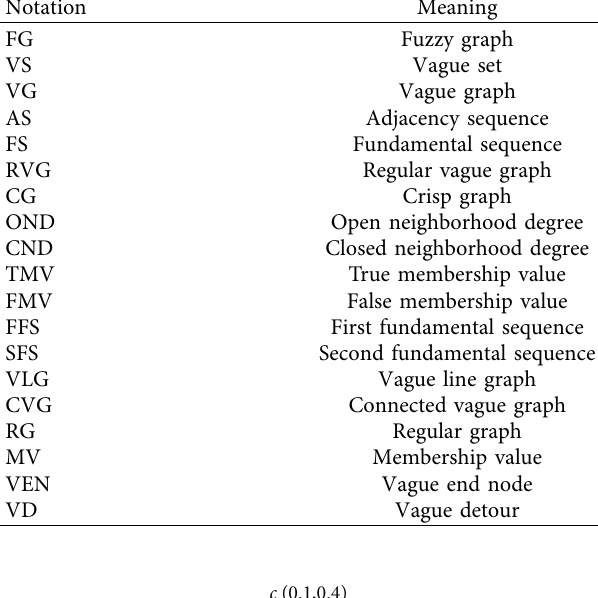
Table 1: Some basic notations.